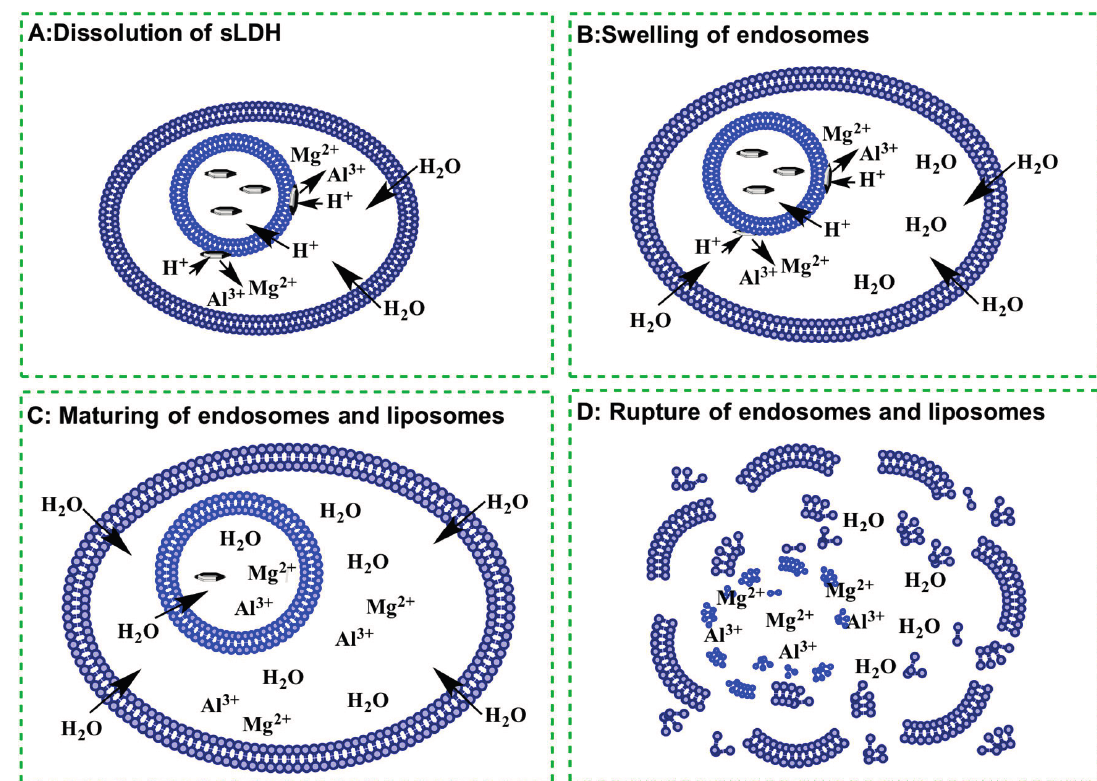
Figure 7. Possible endosomal escape pathway for sLDH–liposome